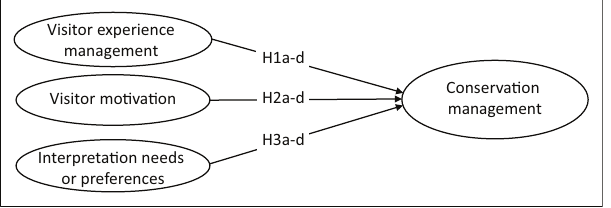
FIGURE 2: Hypothesised regression model.